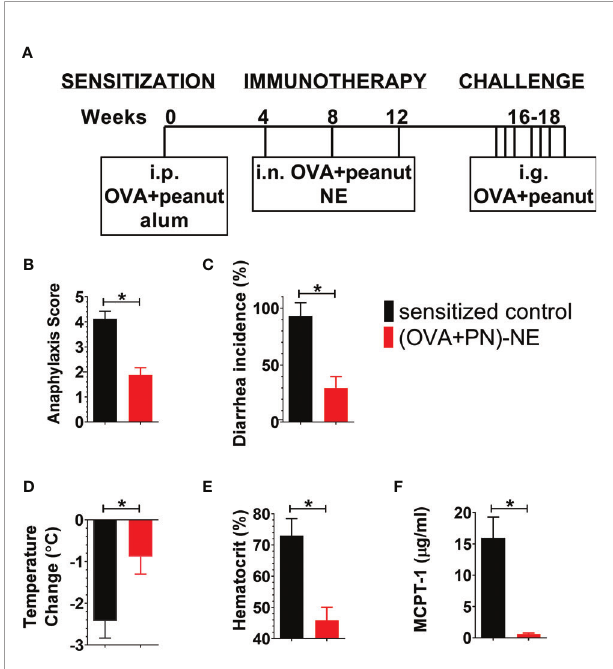
FIGURE 1 | NE immunotherapy protects against allergic reactivity in polysensitized mice. (A) Mice were sensitized with OVA and peanut-alum and treated i.n. with 3 administrations of PBS (sensitized control) or OVA and peanut-NE (OVA+PN-NE) Mice were challenged orally with OVA and peanut and (B) symptoms of anaphylaxis, (C) diarrhea and (D) temperature change were monitored. (E) Hemoconcentration was determined by hematocrit. (F) Levels of MCPT-1 in the serum 60 min after challenge were determined by ELISA. Statistically signi fi cant differences (p < 0.05) are indicated by